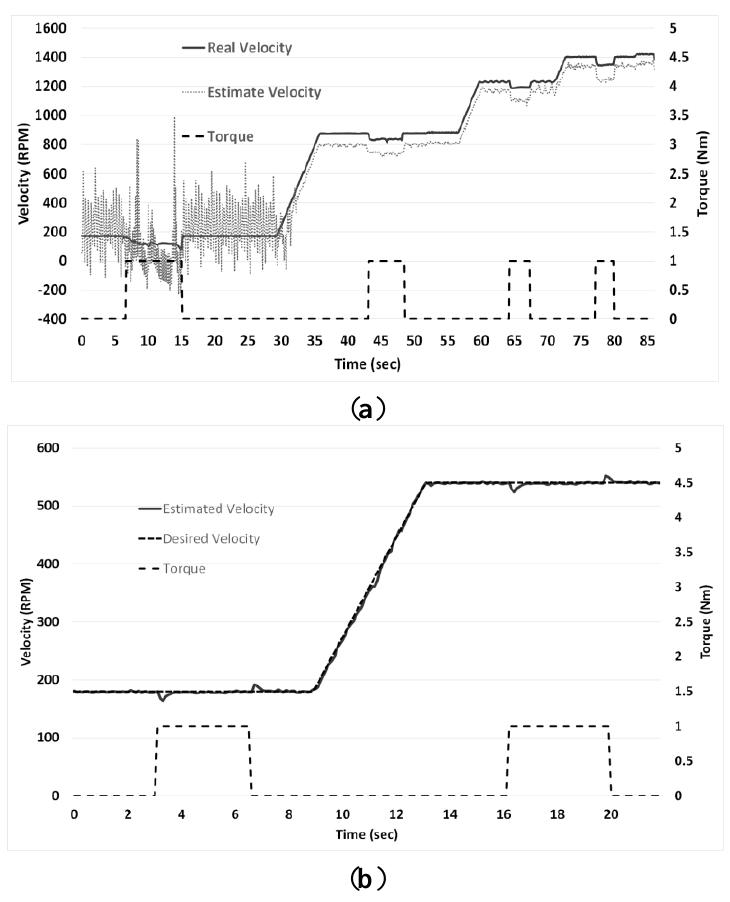
Figure 7. ( a ) FOC without ANN estimator response and ( b ) FOC with the